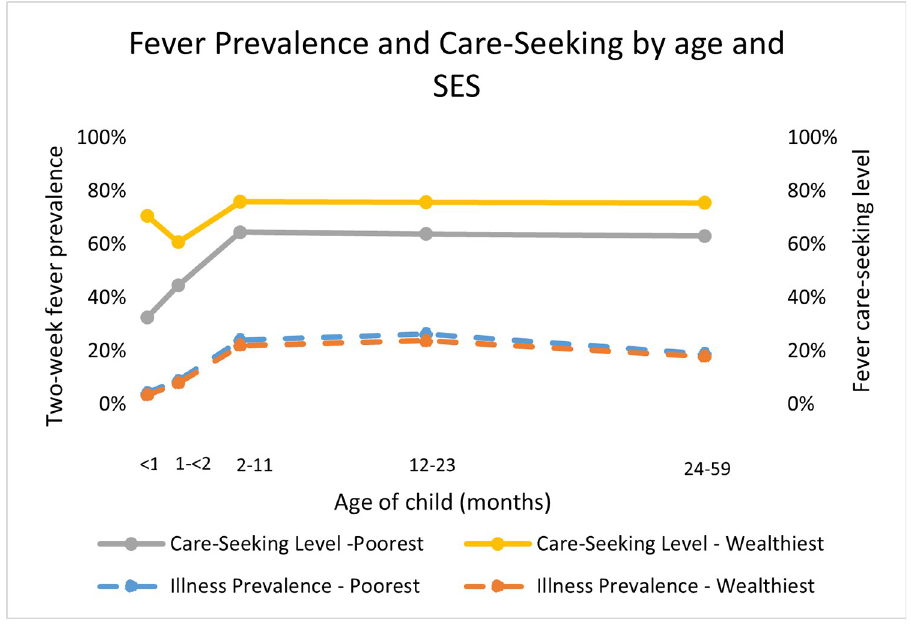
outside the home compared with 71 percent of neonates from the wealthiest families. Note that when the number of neonates with fever is disaggregated by wealth quintile, sample sizes are small (n = 25–49) and should be interpreted with caution. The care-seeking level among the poorest families increased with the child’s age to 45 percent among the poorest families with young infants 30–59 days old and increased further to 65 percent among the poorest fam- ilies with infants 2–11 months old (Fig 7). This level remained consistent for children 12–59 months from the poorest families. The socioeconomic disparity in care seeking was greatest for neonates and narrower for older children.